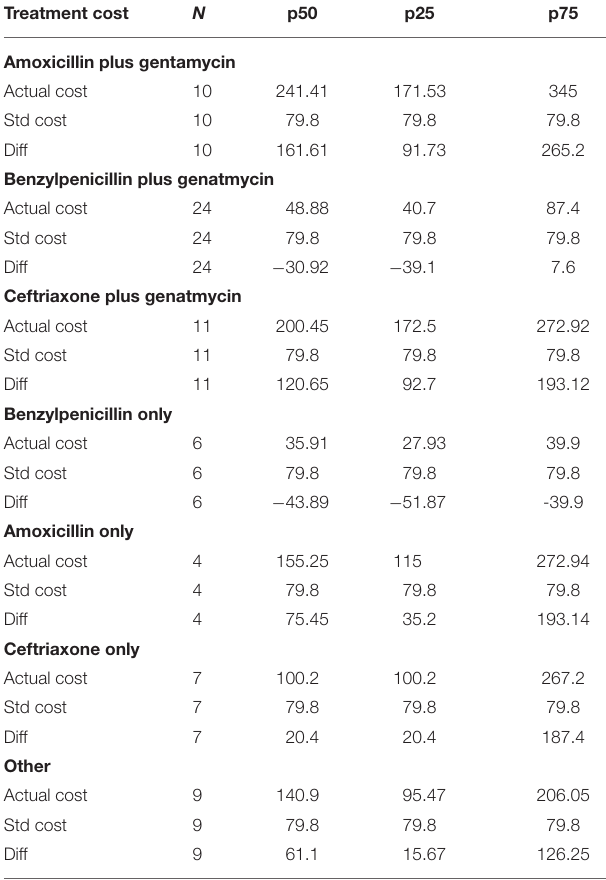
TABLE 3 | Cost comparison